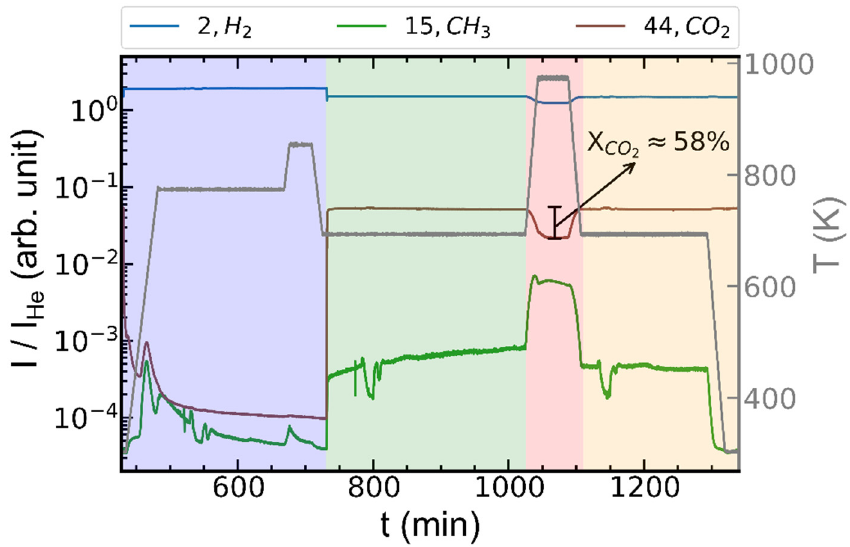
Figure 2. Mass spectrometry (MS) data showing consumption of H 2 (m/z = 2) and CO 2 (m/z = 44), and formation of CH 4 (attributed to CH 3+ ion m/z = 15) during tomography experiments. Traces were normalized to He (m/z = 4). Colored regions indicate: activation (blue); reaction conditions (green); thermal aging (red); reaction conditions after aging (orange). X CO2 indicates CO 2 conversion during thermal aging. Timescale includes 3 tomography measurement series and condition changes.